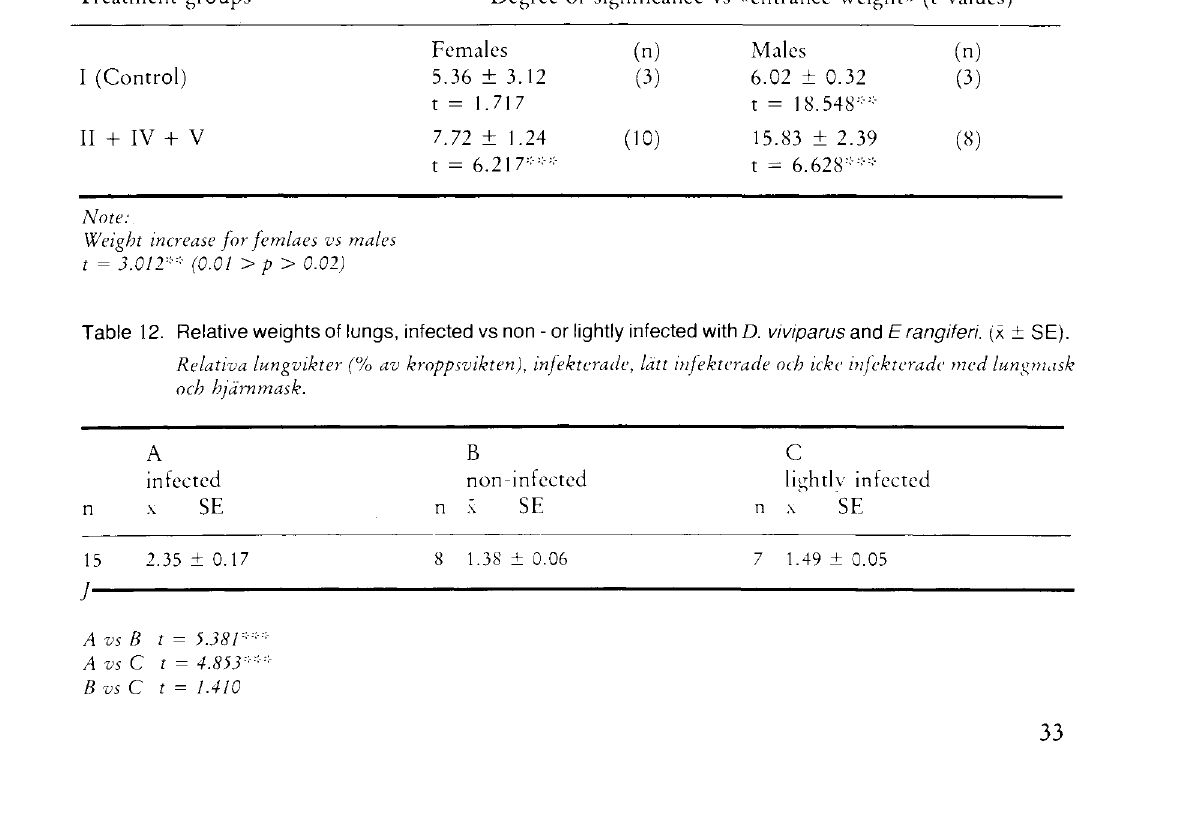
Table 11. Interaction on body weight, during the interval of 0-50 days, females and males separately. Den relativa kroppstillviixten under hela forsøksperioden, hon - och hankon dtskilda.